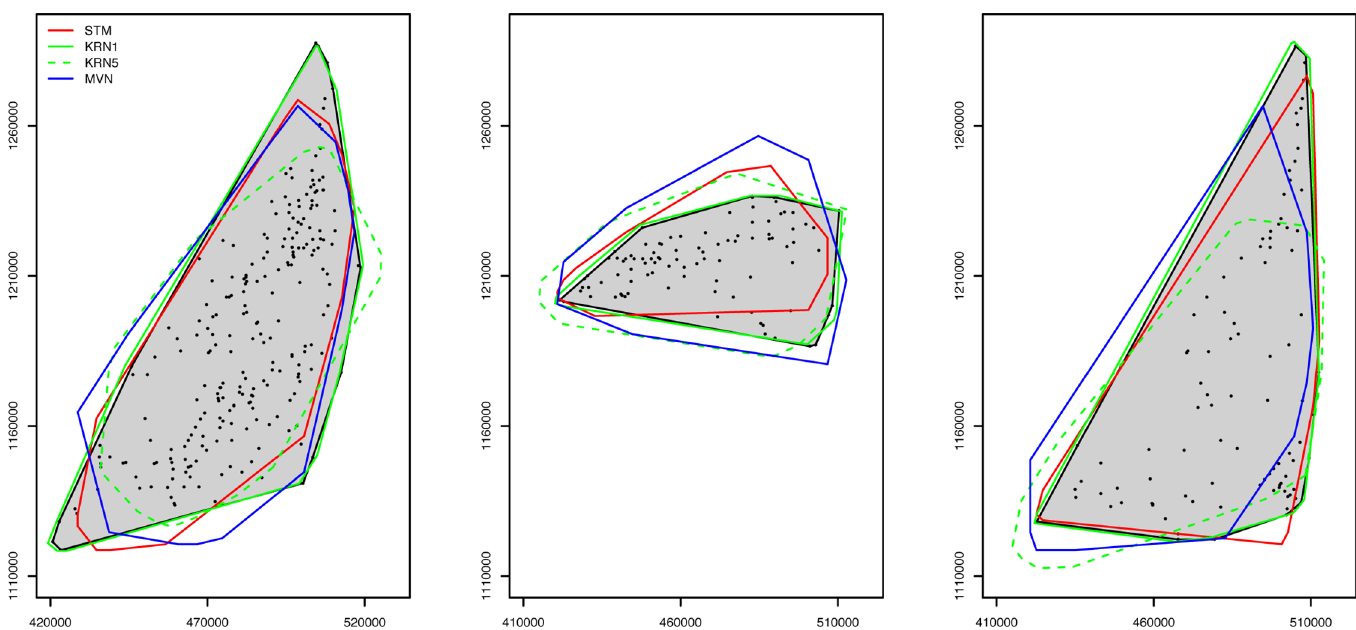
Fig 13. The convex hulls of the data (shaded) and of simulation results for year 2007 – 2008. The dots represent the locations of the pastoralists in the survey data. Pastoralist groups 1 through 3 are represented in the left, center, and right maps, respectively. For each group, only one example of the 100 simulations is